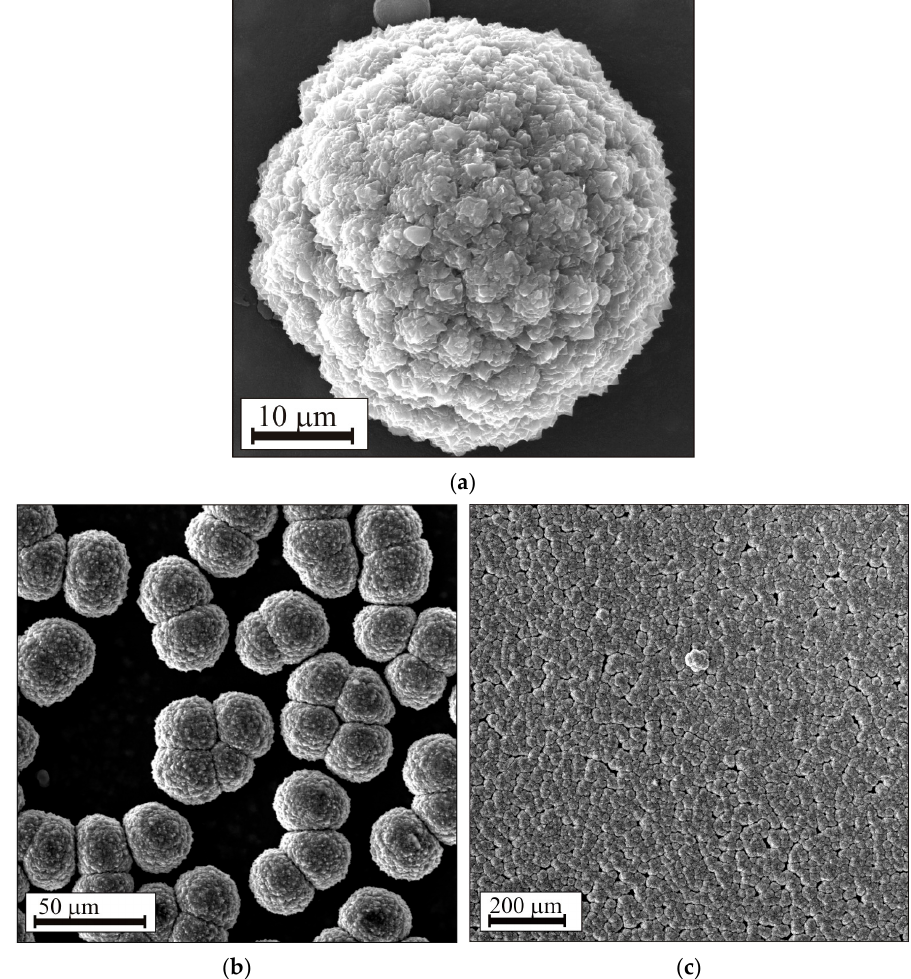
Figure 2. Porous coating formed of SiC nanoparticles from 10 to 80 nm in size, agglomerated into clusters. ( a ) SiC nanoparticles ranging in size from 10 to 80 nm agglomerated into clusters up to several tens of microns in size; ( b ) clusters in an ordered structure on the surface of the material; ( c ) resulted porous coating in one or more layers.